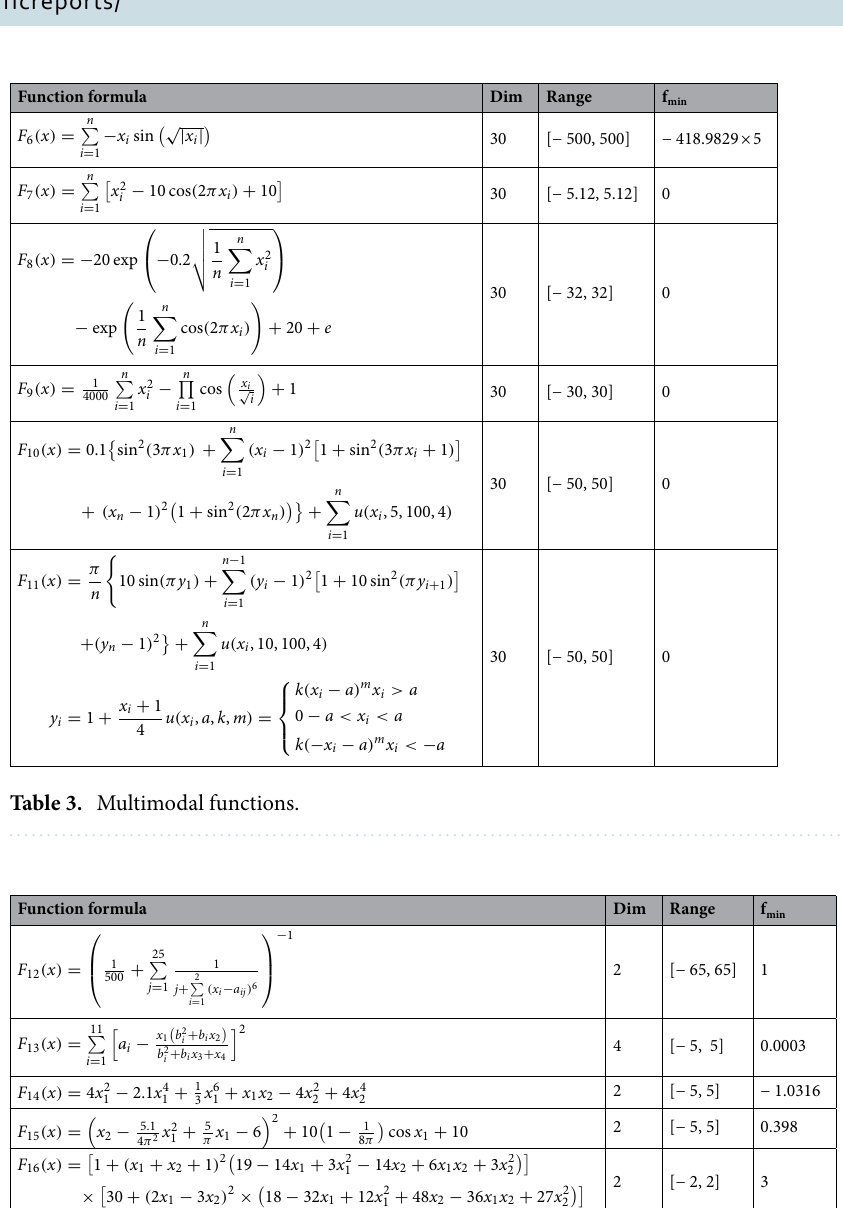
As shown in Table 5, statistics of the optimal value, average value and worst value of the CG-GWO algorithm on all benchmark functions were at the optimal level. Experiments were given the same initial population size and number of iterations. On the benchmark function F12, our approach and other four classical optimization algorithms in the experiment could all find the optimal value. However, the average value, worst value and standard deviation of our approach were significantly better. In contrast, on the benchmark functions F1, F2, F3, F4, F7, F9, and F10, our approach had shown absolute superiority compared with other classic optimization algorithms in the experiment. All statistics were several orders of magnitude higher. On the benchmark func- tions F5 and F13, although the effect of our approach was not so obvious, it was better than other four classic optimization algorithms in the experiment in terms of all statistics. On the benchmark functions F6 and F8, both the CG-GWO algorithm and the WOA algorithm had found the optimal value, but our approach was more concentrated and more stable. As shown in Table 6, the CG-GWO algorithm showed great superiority on unimodal functions compared with a series of improved algorithms of GWO. Especially on the benchmark functions F1, F2, and F3, the optimal value, average value, worst value and standard deviation are far superior to other improved GWO algorithms in the experiment. The stability of our approach can also be clearly seen on the benchmark functions F4 and F5. On multimodal functions, our approach could find the theoretical optimal value well on the benchmark functions F6, F7, F8 and F10. At the same time, all statistics were better than other optimization algorithms in